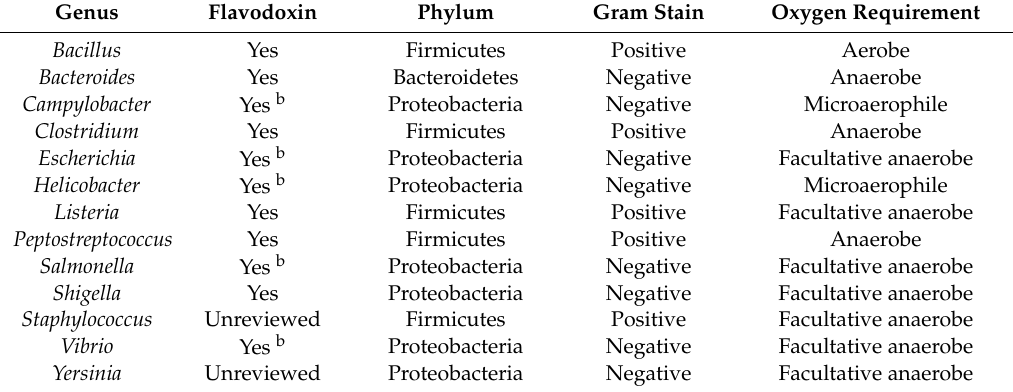
Table 5. Flavodoxin in human gastrointestinal pathogens a